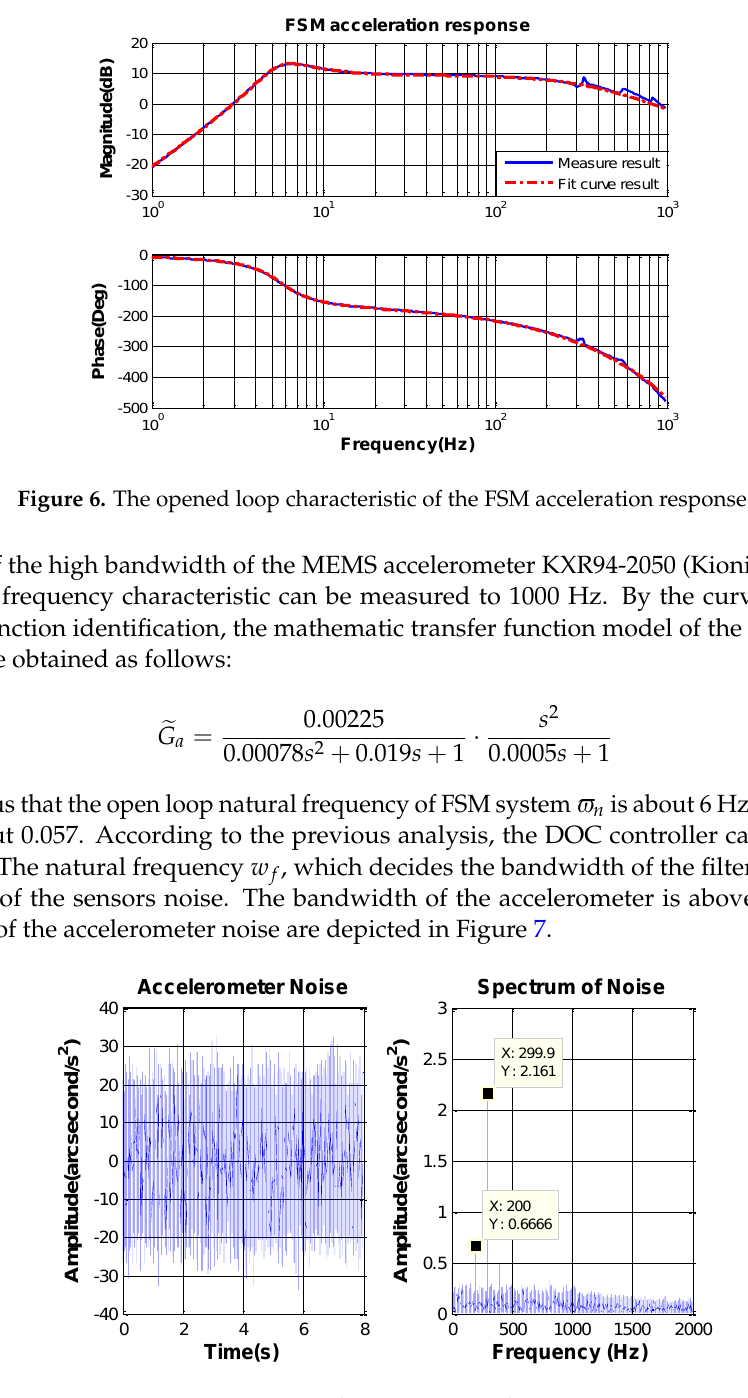
Figure 7. MEMS accelerometer noise characteristics.